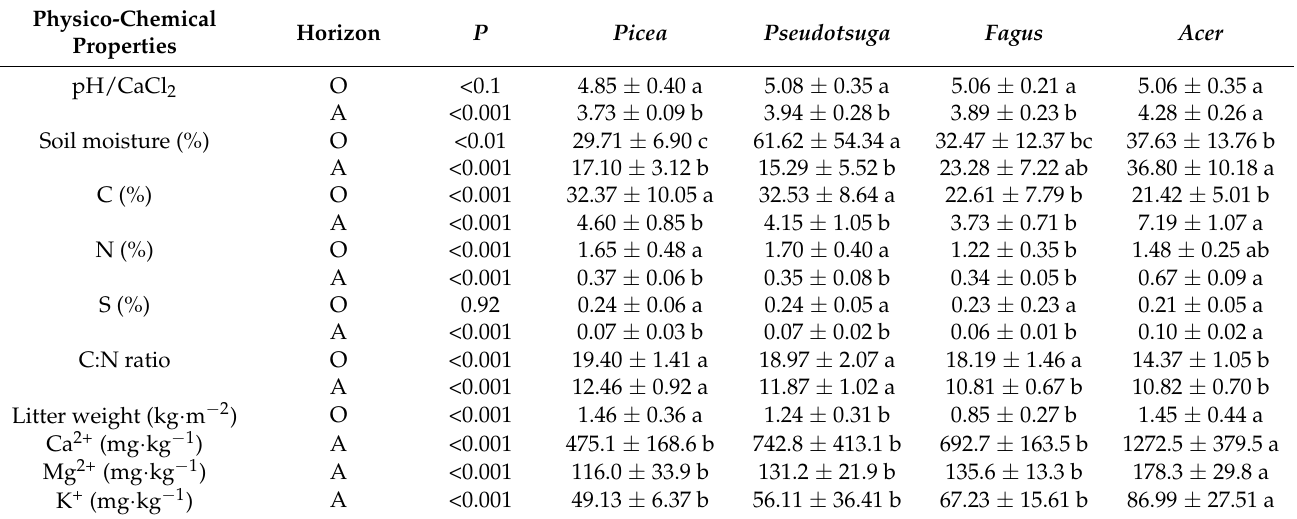
Table 1. Basic statistics (means ± standard deviations) of physico-chemical soil properties in stands of different tree